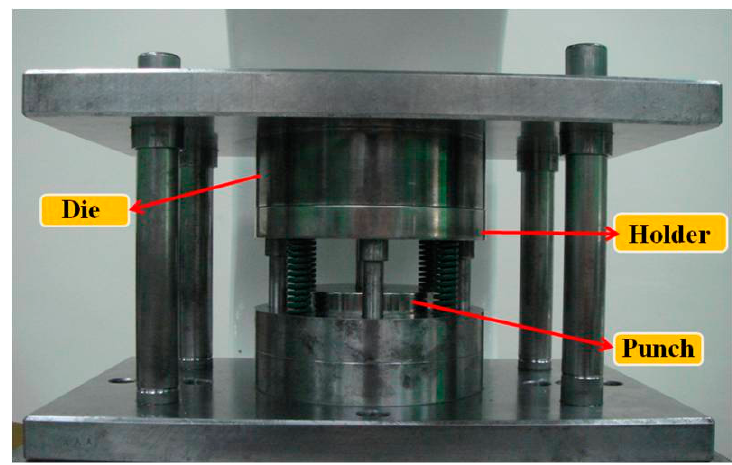
Figure 7. The test rig for the micro-channel array forming process.